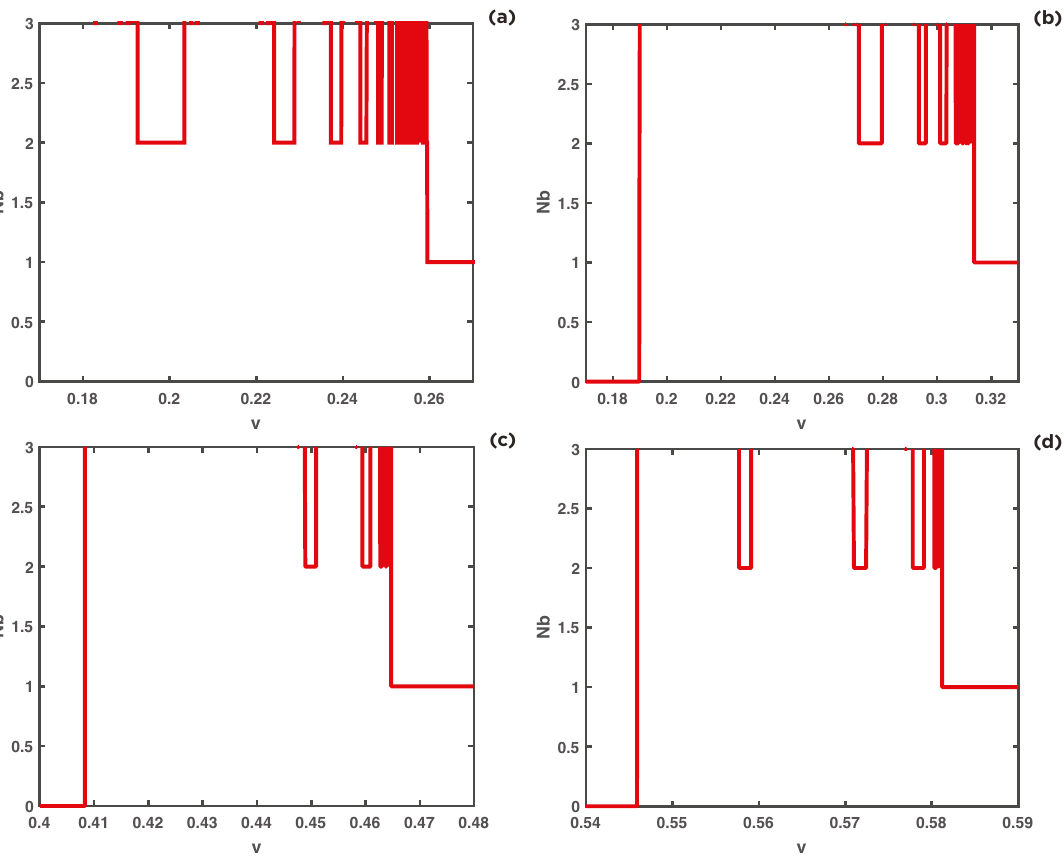
Figure 2 . False vacuum in an unbounded interval: kink-antikink collisions. Number of bounces versus initial velocity v for (a) (cid:15) = 0, (b) (cid:15) = 0 : 001, (c) (cid:15) = 0 : 005 and (d) (cid:15) = 0 : 01.